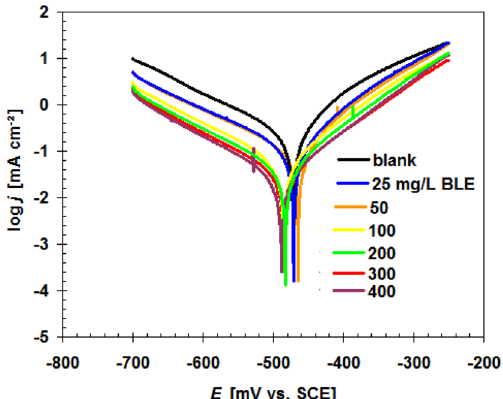
Figure 5. Polarization curves for X52-steel corrosion in pickling solution (1.0 M HCl) with and without varying concentrations of BLE extract at 298 K.